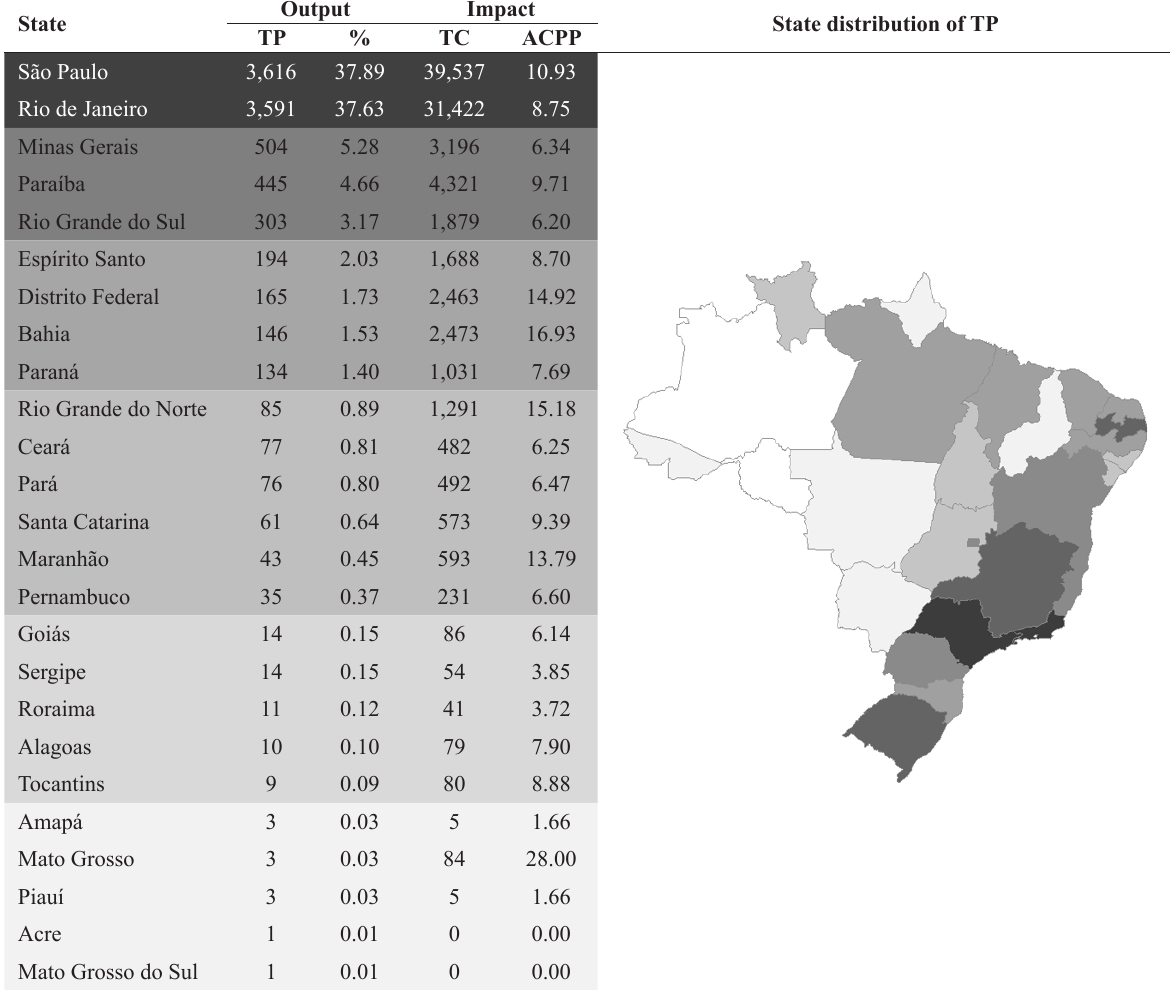
Distribution per state of Brazilian HEP scientific output, 1983-2013.